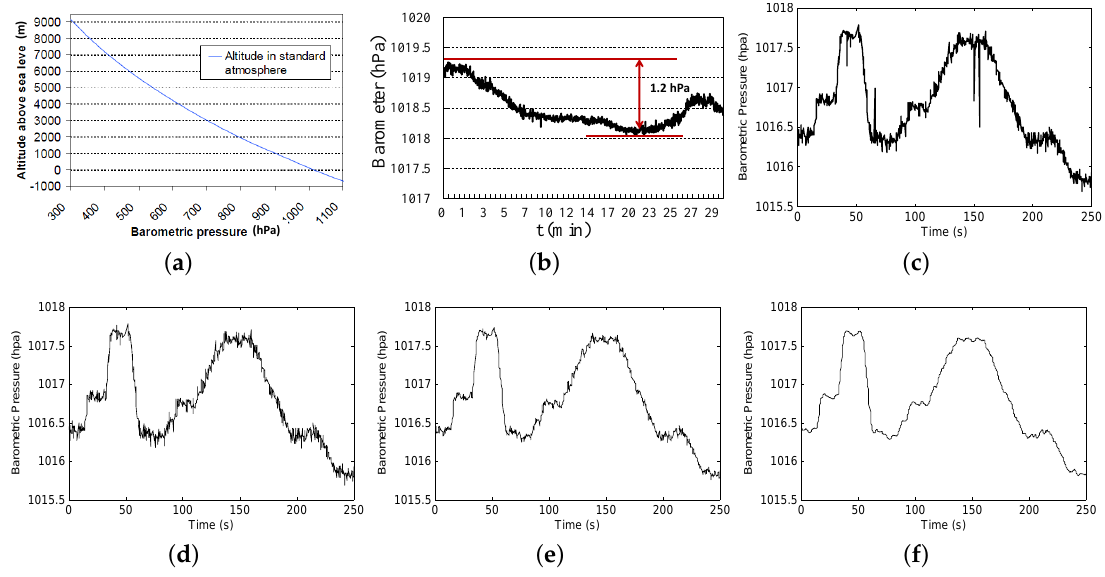
Figure 2. Barometric pressure and barometer readings. ( a ) Variation in atmospheric pressure with altitude; ( b ) barometric pressure changes over time; ( c ) an example of raw barometer readings; ( d ) filtering the isolated points; ( e ) filtering high frequency data; ( f ) smoothing the readings.